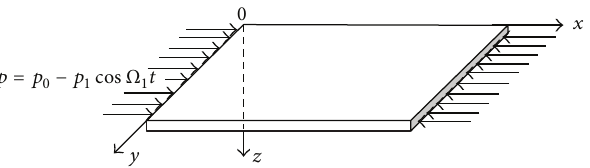
Figure 1: The model of a rectangular thin plate subjected to para- metrical